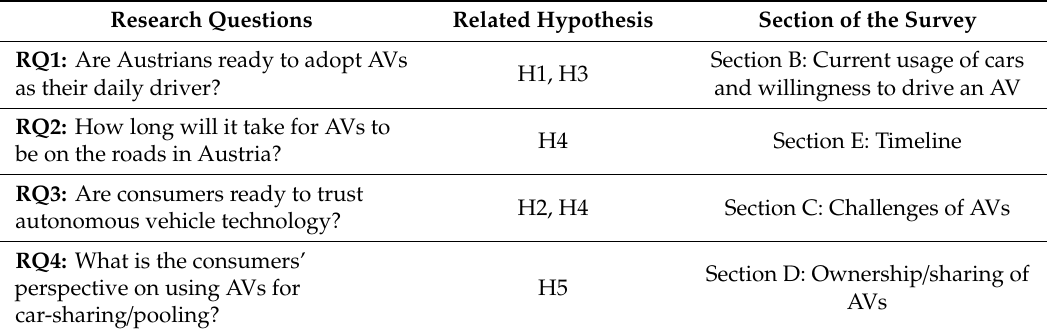
Table 5. Grouping of survey questions to assess the